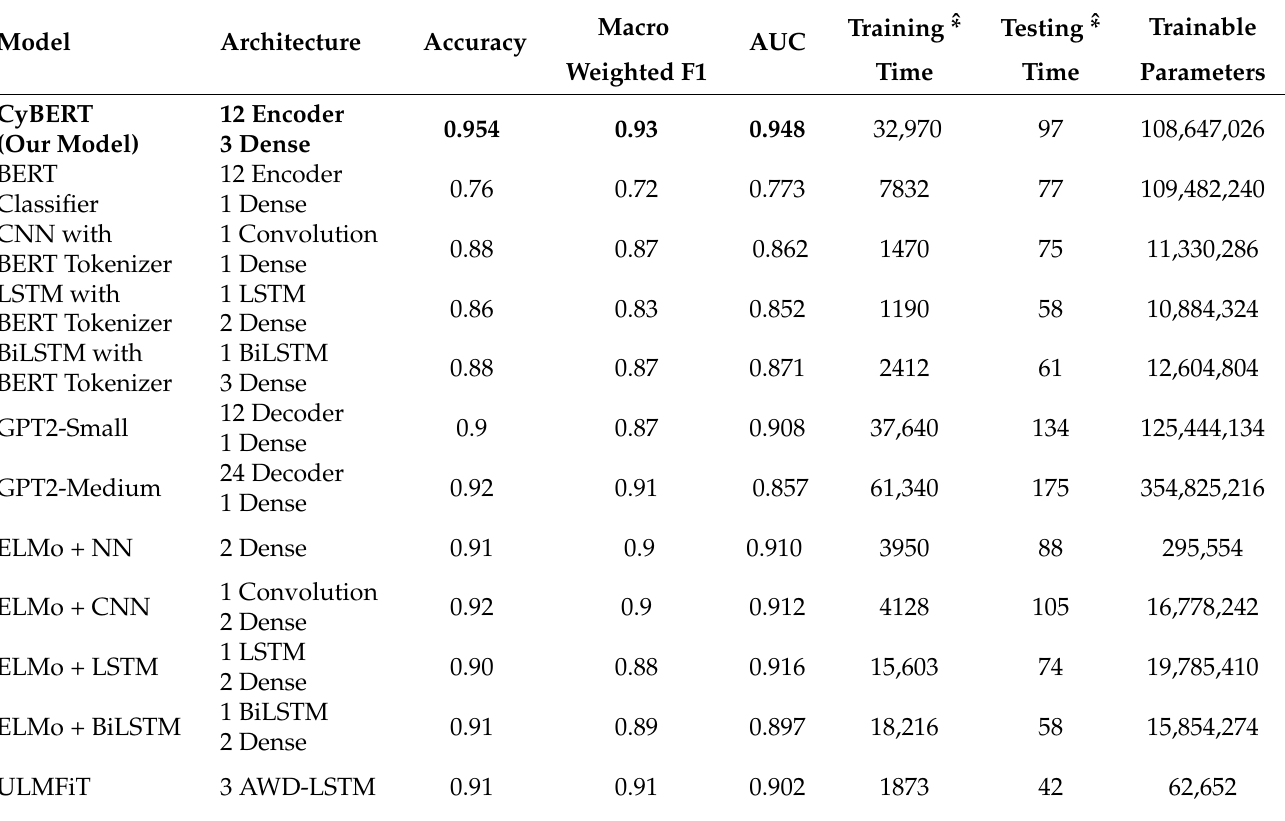
Table 12. Comparison across all tested